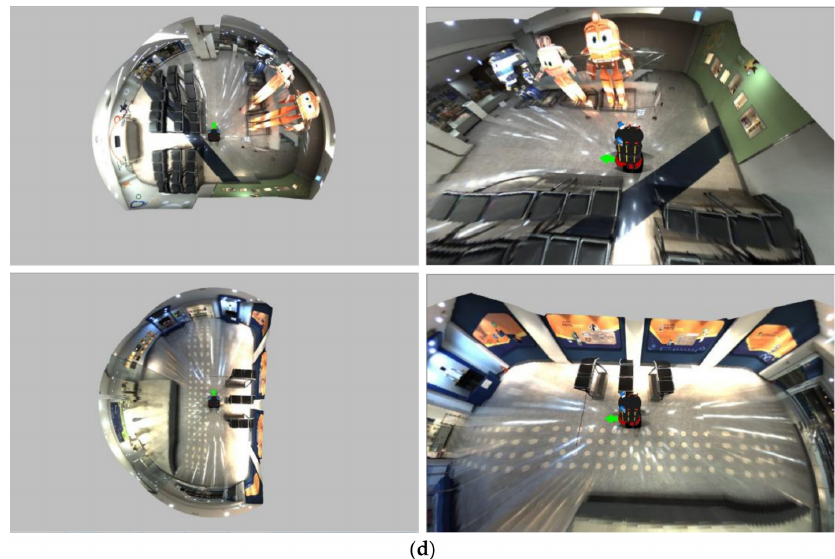
Figure 17. Result comparisons of four methods in the same viewpoint. ( a ) Ground truth, ( b ) SLAM [17–19], ( c ) existing WAVM [10], ( d ) proposed system.